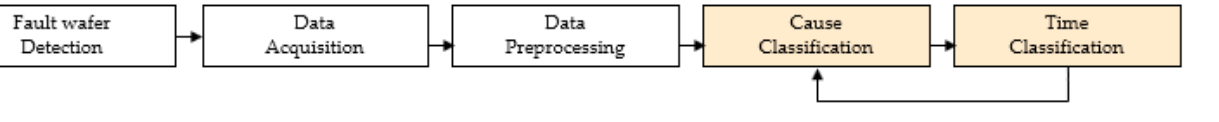
Figure 2. Time analytics model flow chart. Time classification is used to construct a new cause clas- sification algorithm. classification